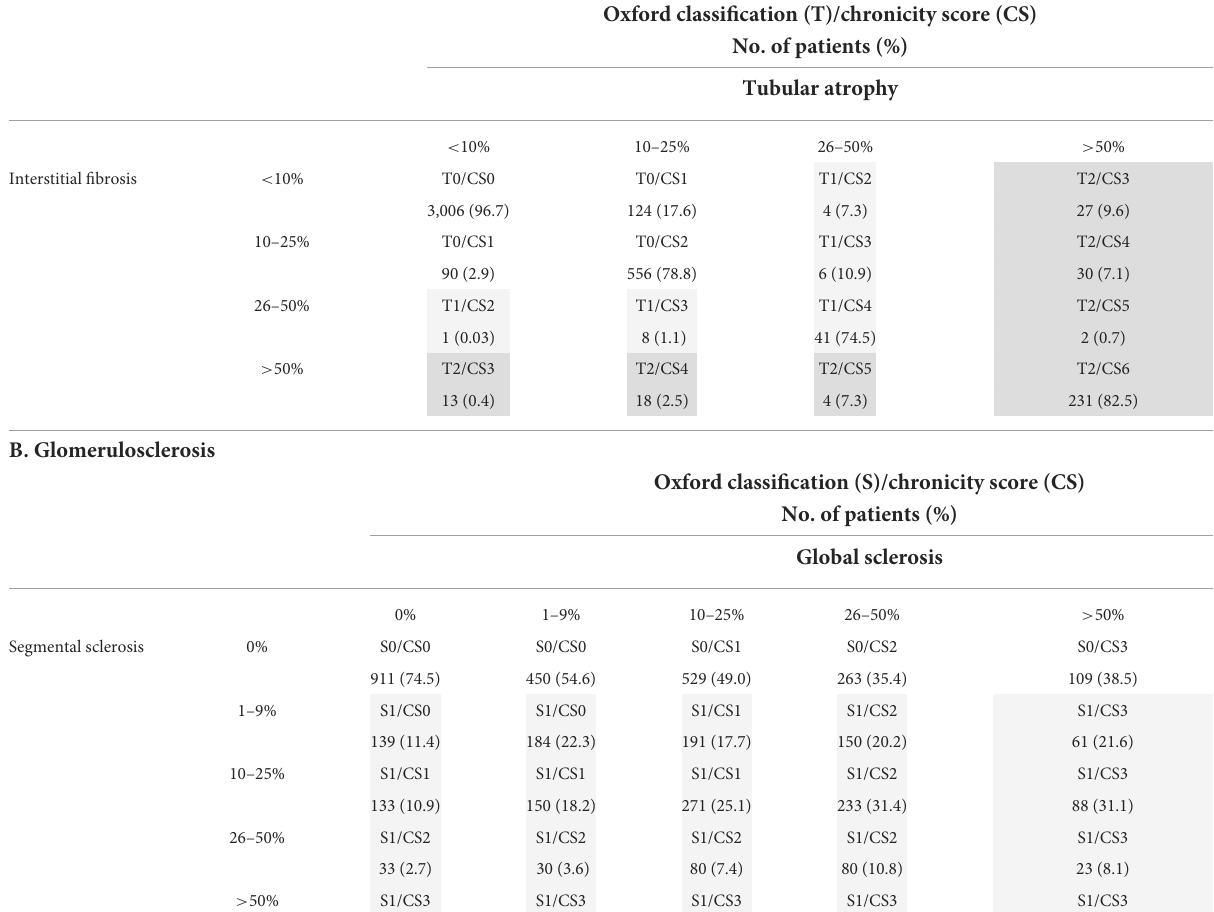
TABLE 3 Comparison of interstitial fibrosis/tubular atrophy lesions and glomerulosclerosis